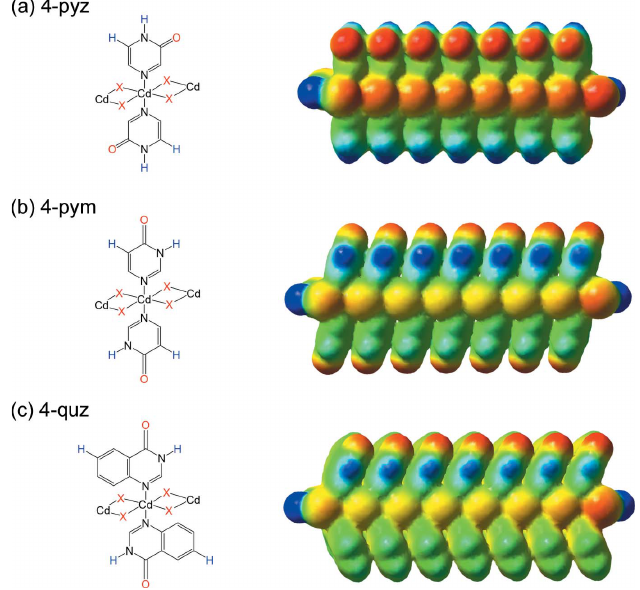
Figure 12 The positions of the atoms with the most positive (blue) and most negative (red) molecular electrostatic potential values for ( a ) pyrazinone- (in complexes 1 – 3 ), ( b ) pyrimidinone- (in complexes 4 – 6 ) and ( c ) quinazolinone-based units (in complexes 7 and 8 , and in the hypothetical model of complex 9 ) presented for polymer fragments consisting of seven cadmium(II) centres for compounds 2 , 5 and 8 , respectively. Isodensity surface of 0.002 a.u., colour range (cid:4) 215 (red) to 310 kJ mol (cid:4) 1